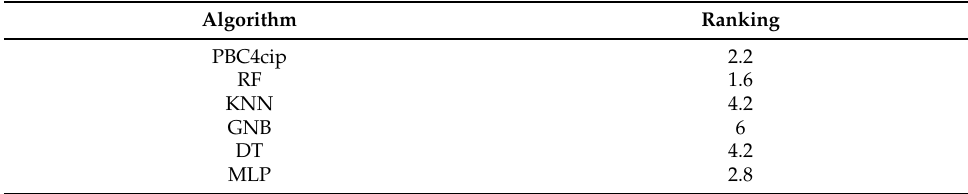
Table 8. Average Rankings of the algorithms